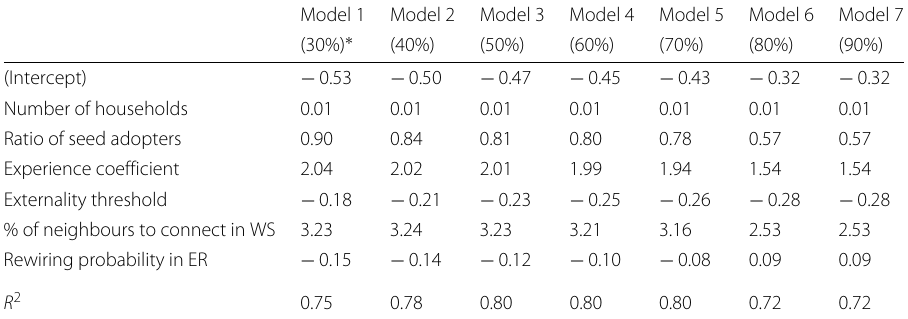
Table 1 Regressions of adoption speed at different diffusion levels (positive externality